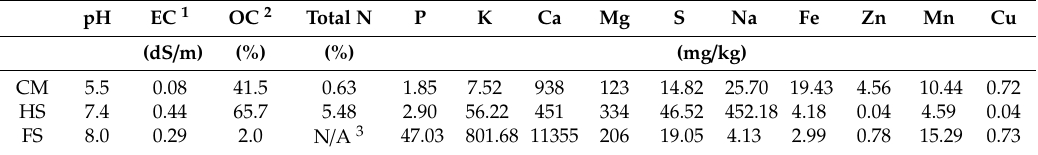
Table 2. Basic chemical properties of the commercial media (CM), humic substances (HS), and field soil (FS). pH EC 1 OC 2 Total N P K